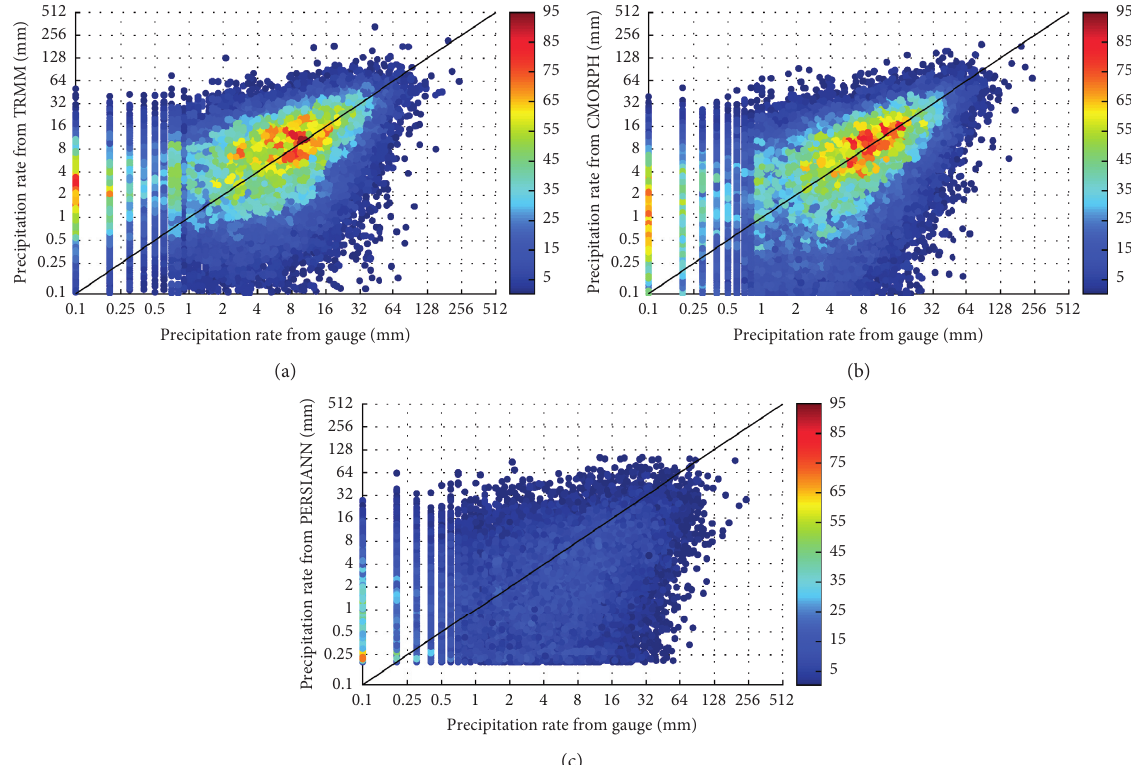
Figure 6: Scatter plot of the observed precipitation and (a) the TRMM, (b) the CMORPH, and (c) the PERSIANN estimates over the Three Gorges Reservoir area in the daytime. Since the minimum scale of a rainfall gauge was 0.1mm, the observed precipitation less than 1mm was displayed as discrete points on the scatter